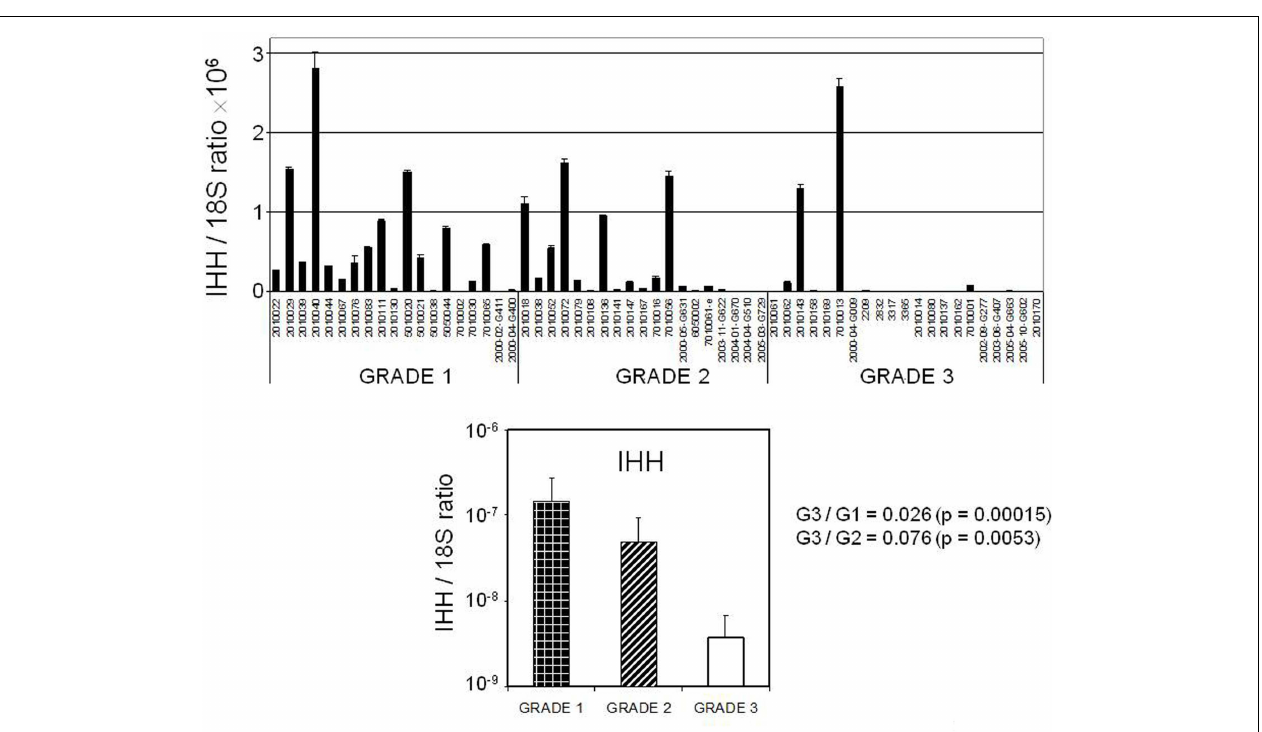
FIGURE 4 | Expression of IHH in all endometrial cancer samples according to tumor grade